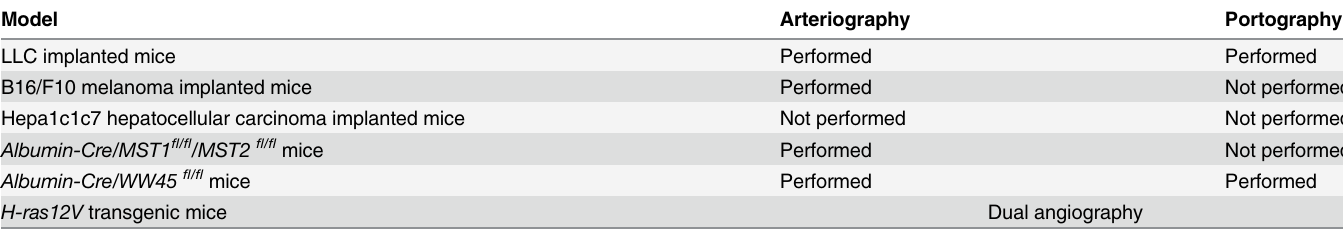
Table 1. Summary of the angiography procedures performed in each tumor